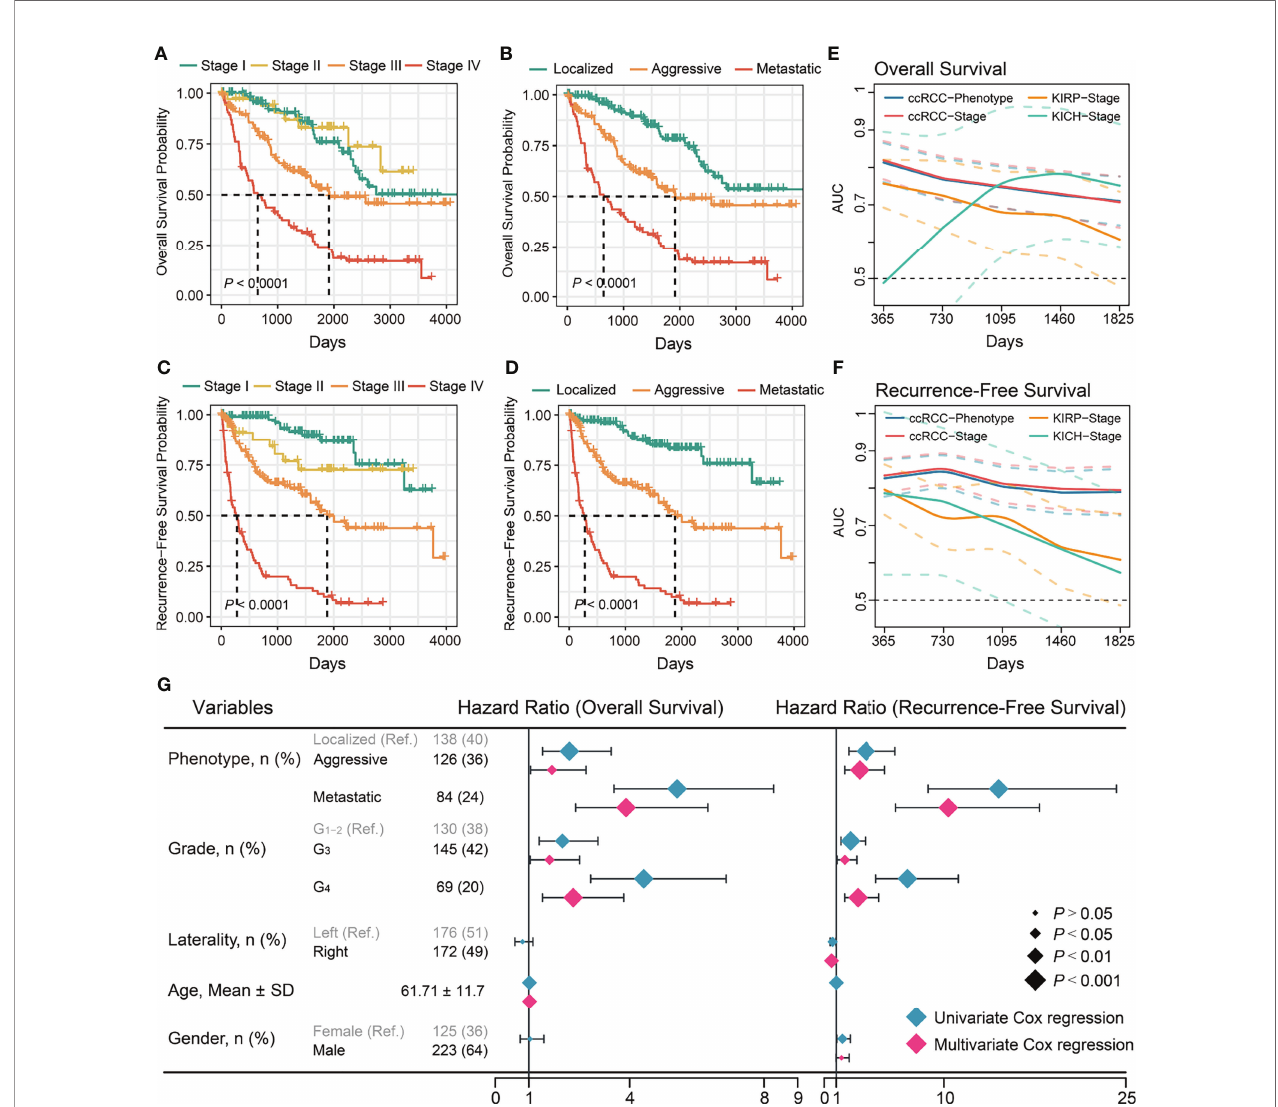
FIGURE 1 | Evaluation of prognostic value of stages and phenotypes of ccRCC in TCGA cohort. (A) Kaplan – Meier curves of OS for stages of ccRCC. (B) Kaplan – Meier curves of OS for phenotypes of ccRCC. (C) Kaplan – Meier curves of RFS for stages of ccRCC. (D) Kaplan – Meier curves of RFS for phenotypes of ccRCC. (E) Time- dependent area under the ROC curve of stages and phenotypes for the OS in ccRCC and others. (F) Time-dependent area under the ROC curve of stages and phenotypes for the RFS in TCGA cohort and others. Ref: Reference group. (G) Forest plot of the univariate and multivariate Cox regression analysis of phenotypes and other clinical information for OS and